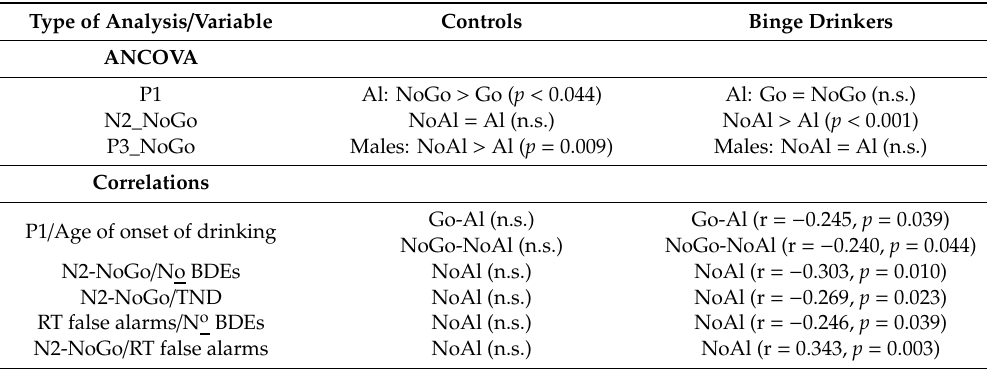
Table 7. Summary of the results where e ff ects of the group factor (control vs. binge drinkers) or interactions with type of trial (Go vs. NoGo) or type of stimulus (Al vs. NoAl) were significant. The associated p-values are shown in parentheses; n.s.: no